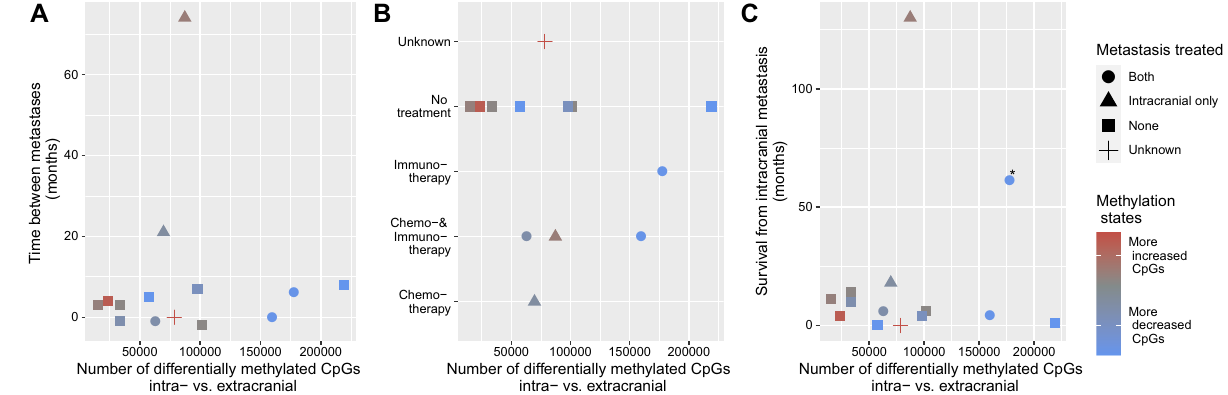
Figure 4. Methylation alterations in the context of clinical information. Visualization of the number of differentially methylated CpGs between intra- and extracranial metastases (x-axis) in the context of different clinical information of each patient (y-axis). Color coding of the plotted symbols defines if the methylation changes include more CpGs with increased methylation (red) or more CpGs with decreased methylation (blue) in intra- compared to extracranial metastases. Shapes of the plotted symbols highlight the treatment status of the individual patients after the occurrence of a metastasis. ( A ) Number of differentially methylated CpGs in the context of the time between both metastases of a patient. Negative time means that the intracranial metastasis occurred before the extracranial metastasis. ( B ) Number of differentially methylated CpGs in relation to treatment status of metastases of individual patients. ( C ) Number of differentially methylated CpGs in relation to survival from intracranial metastasis. Patient P39 was still alive and is marked with an asterisk